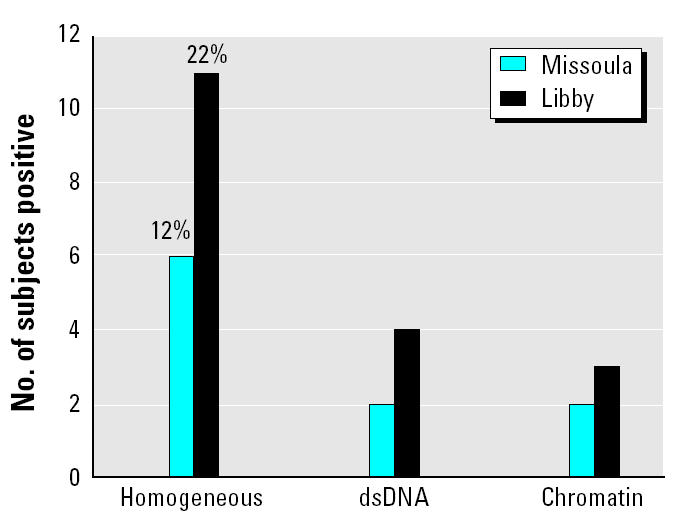
Assessment of autoantibodies targeted to dsDNA or chromatin in subjects with homogeneous ANA patterns. See “Materials and Methods” for details. Tests for antibodies to individual histones were not performed, but that target is indicated for those homogeneous patterns without antibodies to dsDNA or chromatin itself.